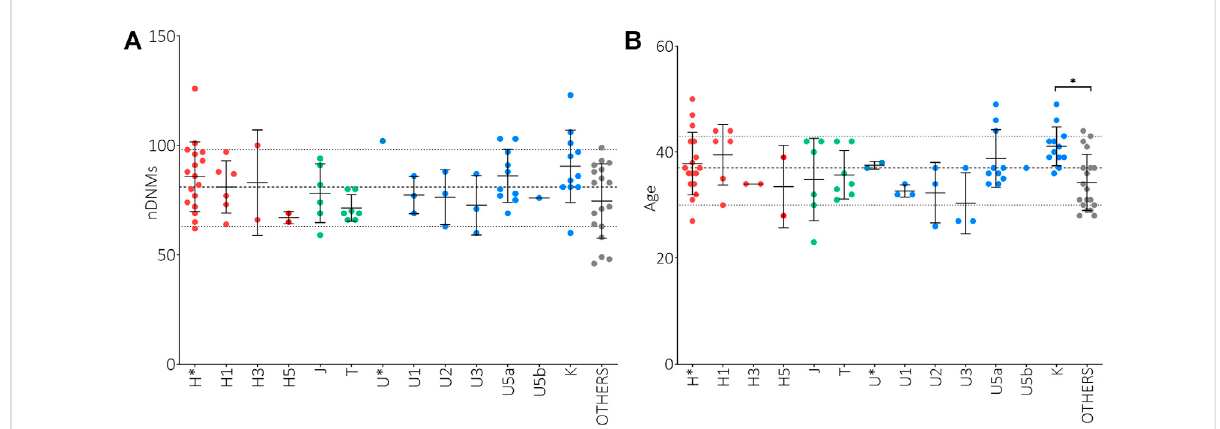
FIGURE 1 Analysis of nuclear de novo mutations (DNMs) in the offspring and paternal age at time of conception in relation to mtDNA haplogroups. (A) Number of nuclear DNMs in ASD probands strati fi ed for paternal sub-haplogroups. (B) Paternal ages at time of conception strati fi ed for sub- haplogroups.OrdinaryOneWayANOVAtestshowedstatisticalsigni fi canceonlyforthefathers ’ ageattimeofconception( p -value=0.0150)andthe Tukey ’ s multiple comparisons test showed a signi fi cance only for K vs. “ Others ” comparisons (* p -value < 0.05). Sub-haplogroups derived from the same root are reported in the same color. Dashed and dotted lines represent mean DNMs number and age ± standard deviations.